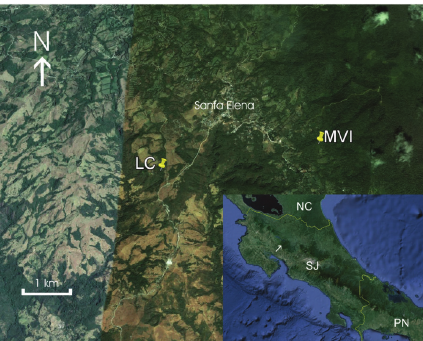
Figure 1: Location of the study area in the Monteverde region of Costa Rica. Sampling was conducted at the Monteverde Institute (MVI) and La Calandria (LC). Capitol city of San Jose shown in inset for reference, along with borders of Nicaragua (NC) and Panama (PN). Adapted from Google Earth® imagery (satellite image acquisition